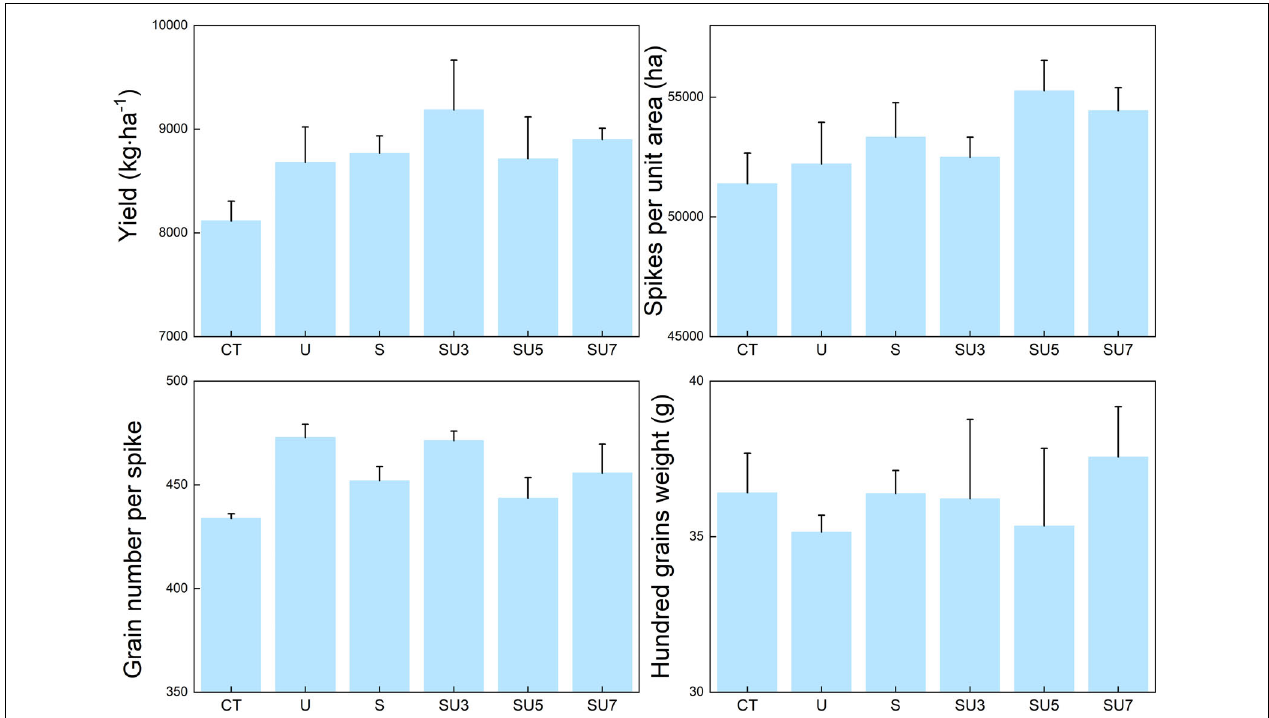
FIGURE 1 | Effect of no fertilizer (CT), regular urea (U), controlled-release urea (S), and different ratios of controlled-release urea to regular urea (SU3, 3:7 ratio of controlled-release urea to regular urea; SU5, 5:5 ratio of controlled-release urea to regular urea; and SU7, 7:3 ratio of controlled-release urea to regular urea) on maize yield, spikes per unit area, grain number per spike and hundred grains weight, N agronomic efficiency, and N partial factors. Regular urea, controlled-release urea, and different ratios of regular urea and controlled-release urea are all applied at a rate of 180 kg ha - 1 . Values are presented as the means ± standard error (SE). Lowercase and uppercase letters indicate significant differences between the nitrogen fertilizer treatment ( p <